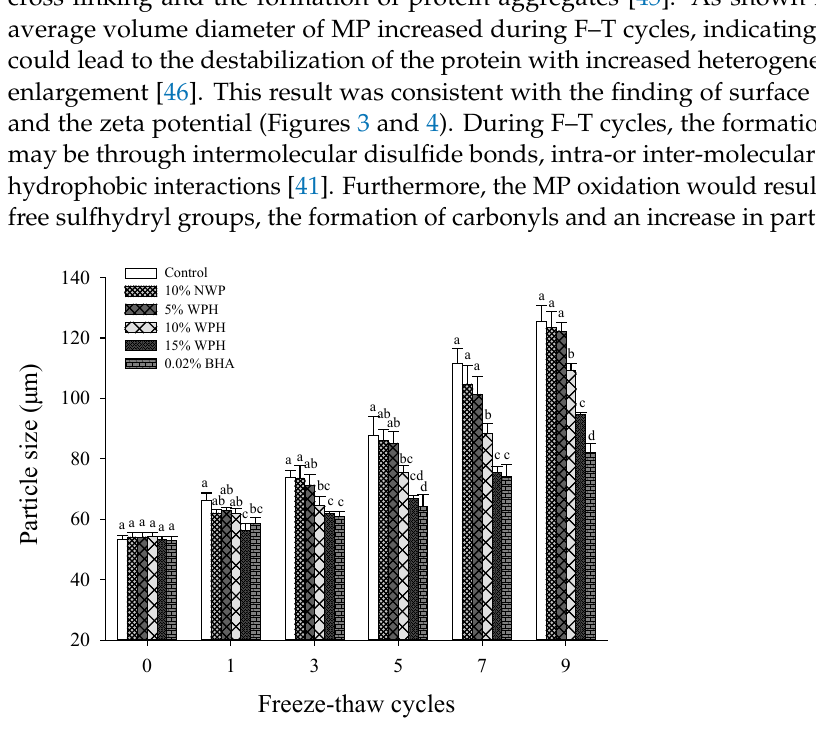
Figure 5. Changes in particle size of myofibrillar protein (MP) of multiple freeze–thaw (F–T) cycles of pork patties with different whey protein hydrolysate (WPH) contents. The significant differences among different samples are indicated by different lowercase letters (a–d). Control: without any additives in the sample; NWP: native whey protein; BHA: butylated hydroxyanisole. Protein with smaller sizes exhibits better emulsification and oxidation stability [47].